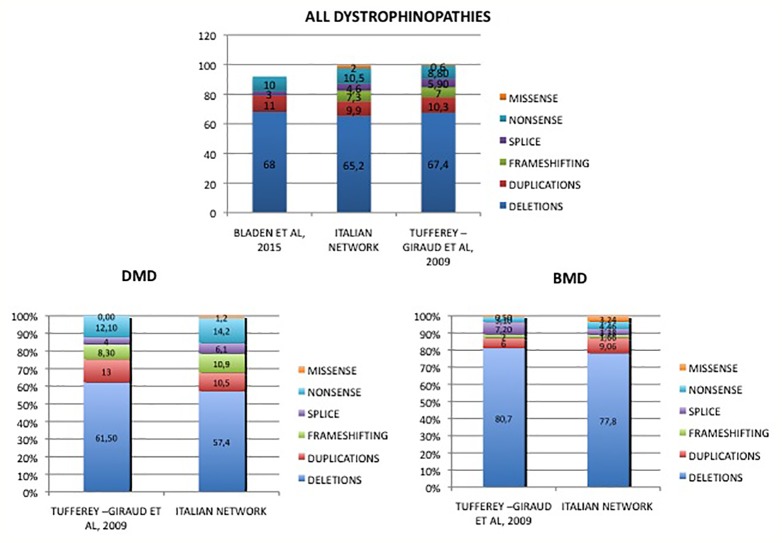
Mutations distribution in DMD and BMD patients from Italy compared to literature data. Overview of genotype data of our cohort in comparison to previously reported other nationwide studies. Tuffery-Giraud et al. (2009). Hum. Mutat. 30, 934-45; Bladen et al. (2015). Hum. Mutat. 36, 395-402.